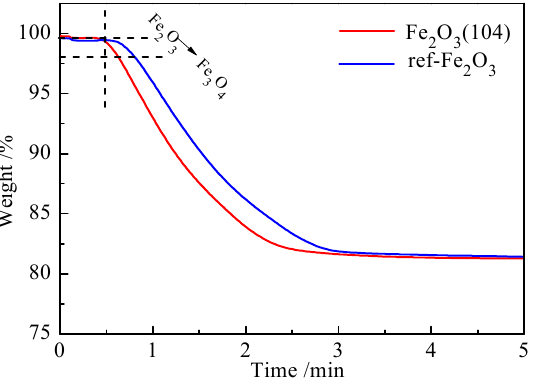
Figure 4. TG/DTG curves for reactions between CO and Fe 2 O 3 (104)/Al 2 O 3 or referenced Fe 2 O 3 /Al 2 O 3 . ( a ) TG curves; ( b ) DTG curves.